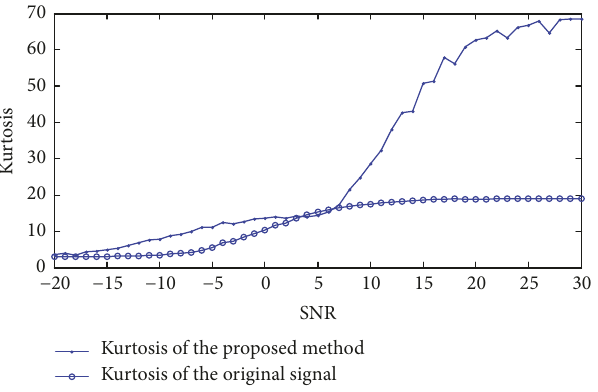
Figure 13: The result of the proposed method for signals with different